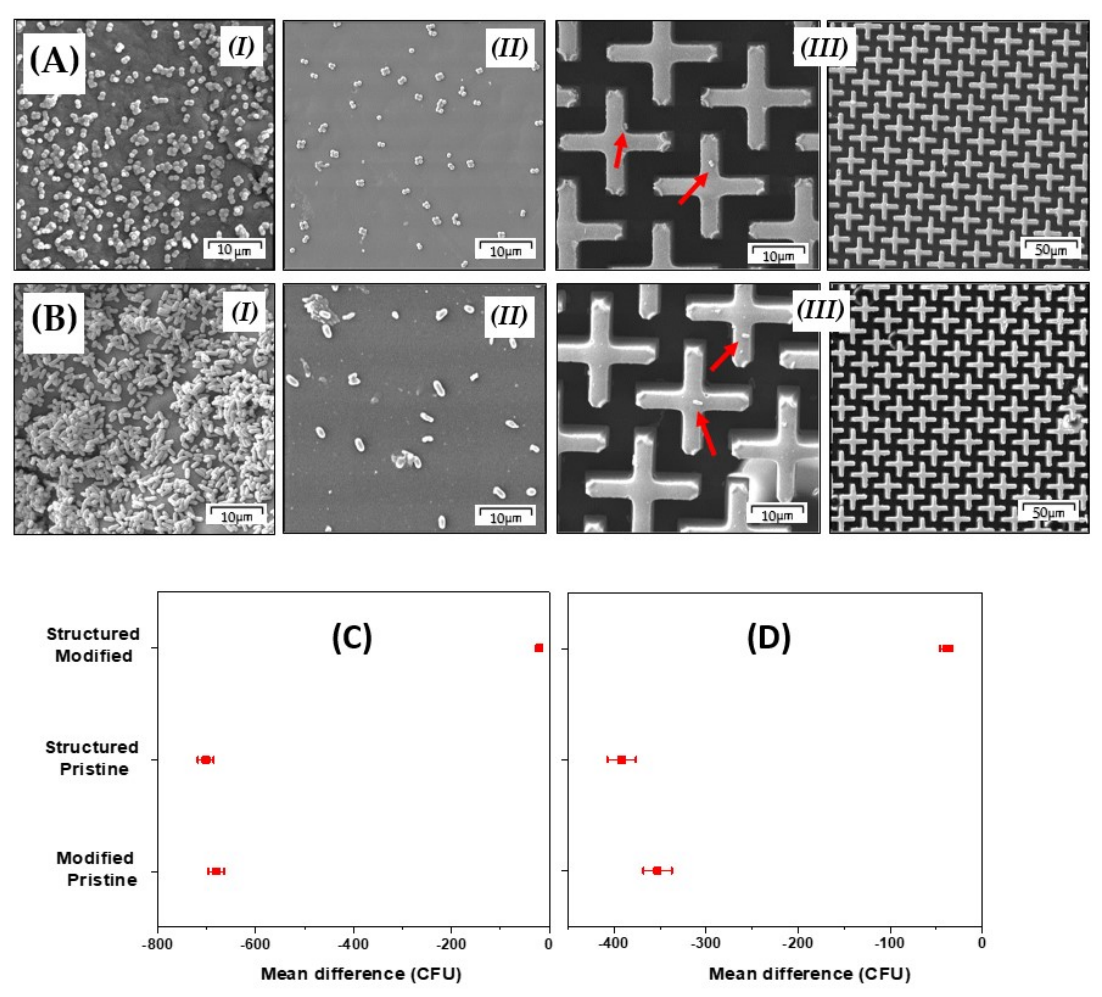
Figure 6. Results of antifouling tests performed by SEM for bacterial strains of S. epidermidis ( A ) and E. coli ( B ); results of analysis of variance one way (ANOVA) between groups for S. epidermidis ( C ) and E. coli ( D ).